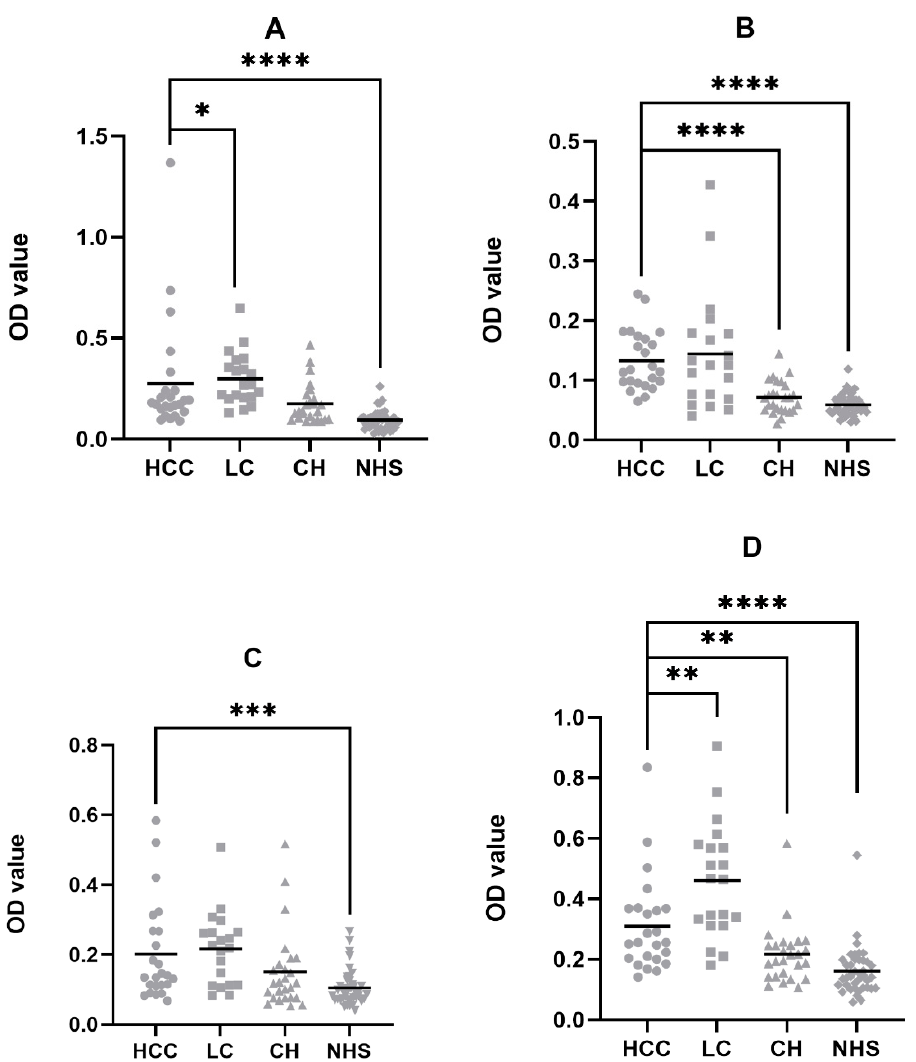
Figure 1. Autoantibody titer distributions of the 4 TAAs in the Hispanic HCC, LC, CH, and NHS groups by ELISA. Mann–Whitney tests show significant optical density (OD) differences between HCC and NHS groups in all 4 anti-TAA autoantibodies. Significant differences were identified between HCC against CH in p16 and HSP60, and HCC against LC in DNMT3A and HSP60. ( A ) DNMT3A; ( B ) p16; ( C ) HSPA5; ( D ) HSP60. HCC: Hepatocellular carcinoma; LC: Liver Cirrhosis;